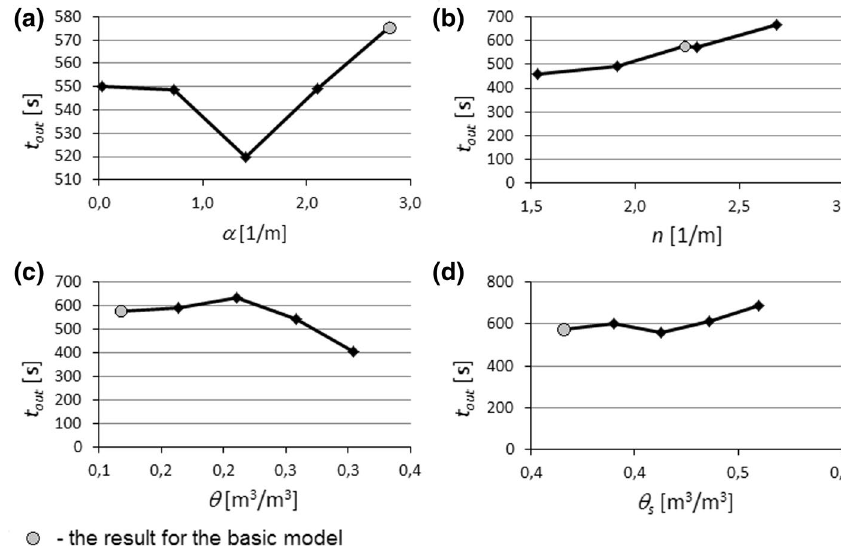
Fig. 1 Graphs of the depend- ence between the time of water outflow on the soil surface after a failure of a buried water pipe ( t out ) and the selected parame- ters: a parameter α , b parameter n , c actual water content in the soil θ , d saturated water content in the soil θ